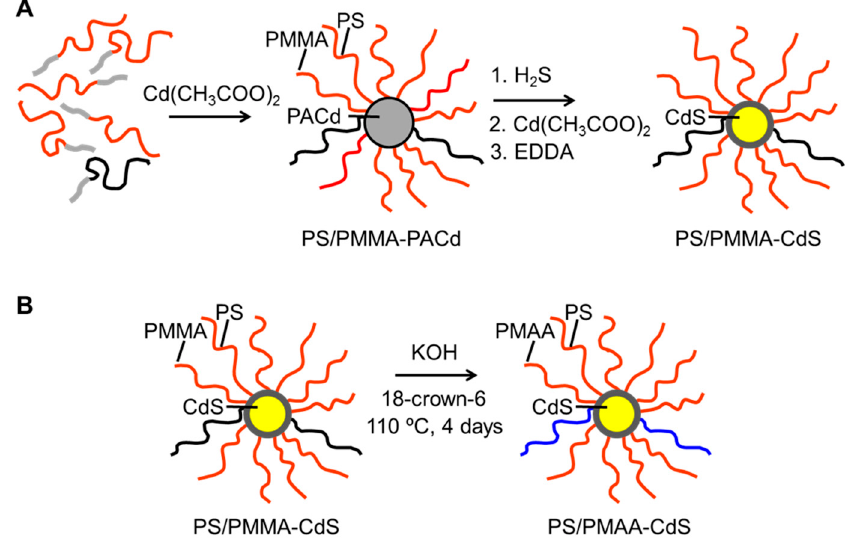
Figure 1. Schematic showing preparation routes ( A ) from block copolymer blend to hydrophobic mixed brush nanoparticle PS/PMMA-CdS and ( B ) from PS/PMMA-CdS to amphiphilic brish nanoparticle PS/PMAA-CdS.